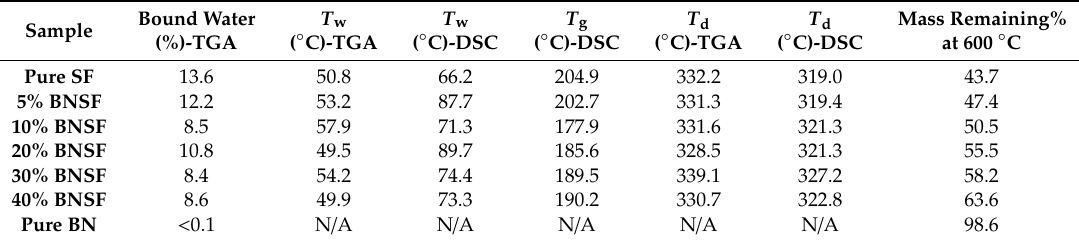
Table 1. Thermal properties of pure silk fibroin (SF) nanofibers, di ff erent boron nitride silk fibroin (BNSF) nanofibers, and raw BN